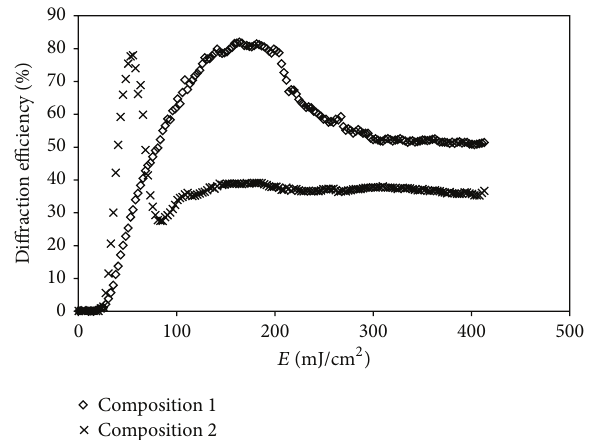
Figure 6: Comparison between the recording processes for compo- sitions 1 and 2 for layers 30 𝜇 m thick.